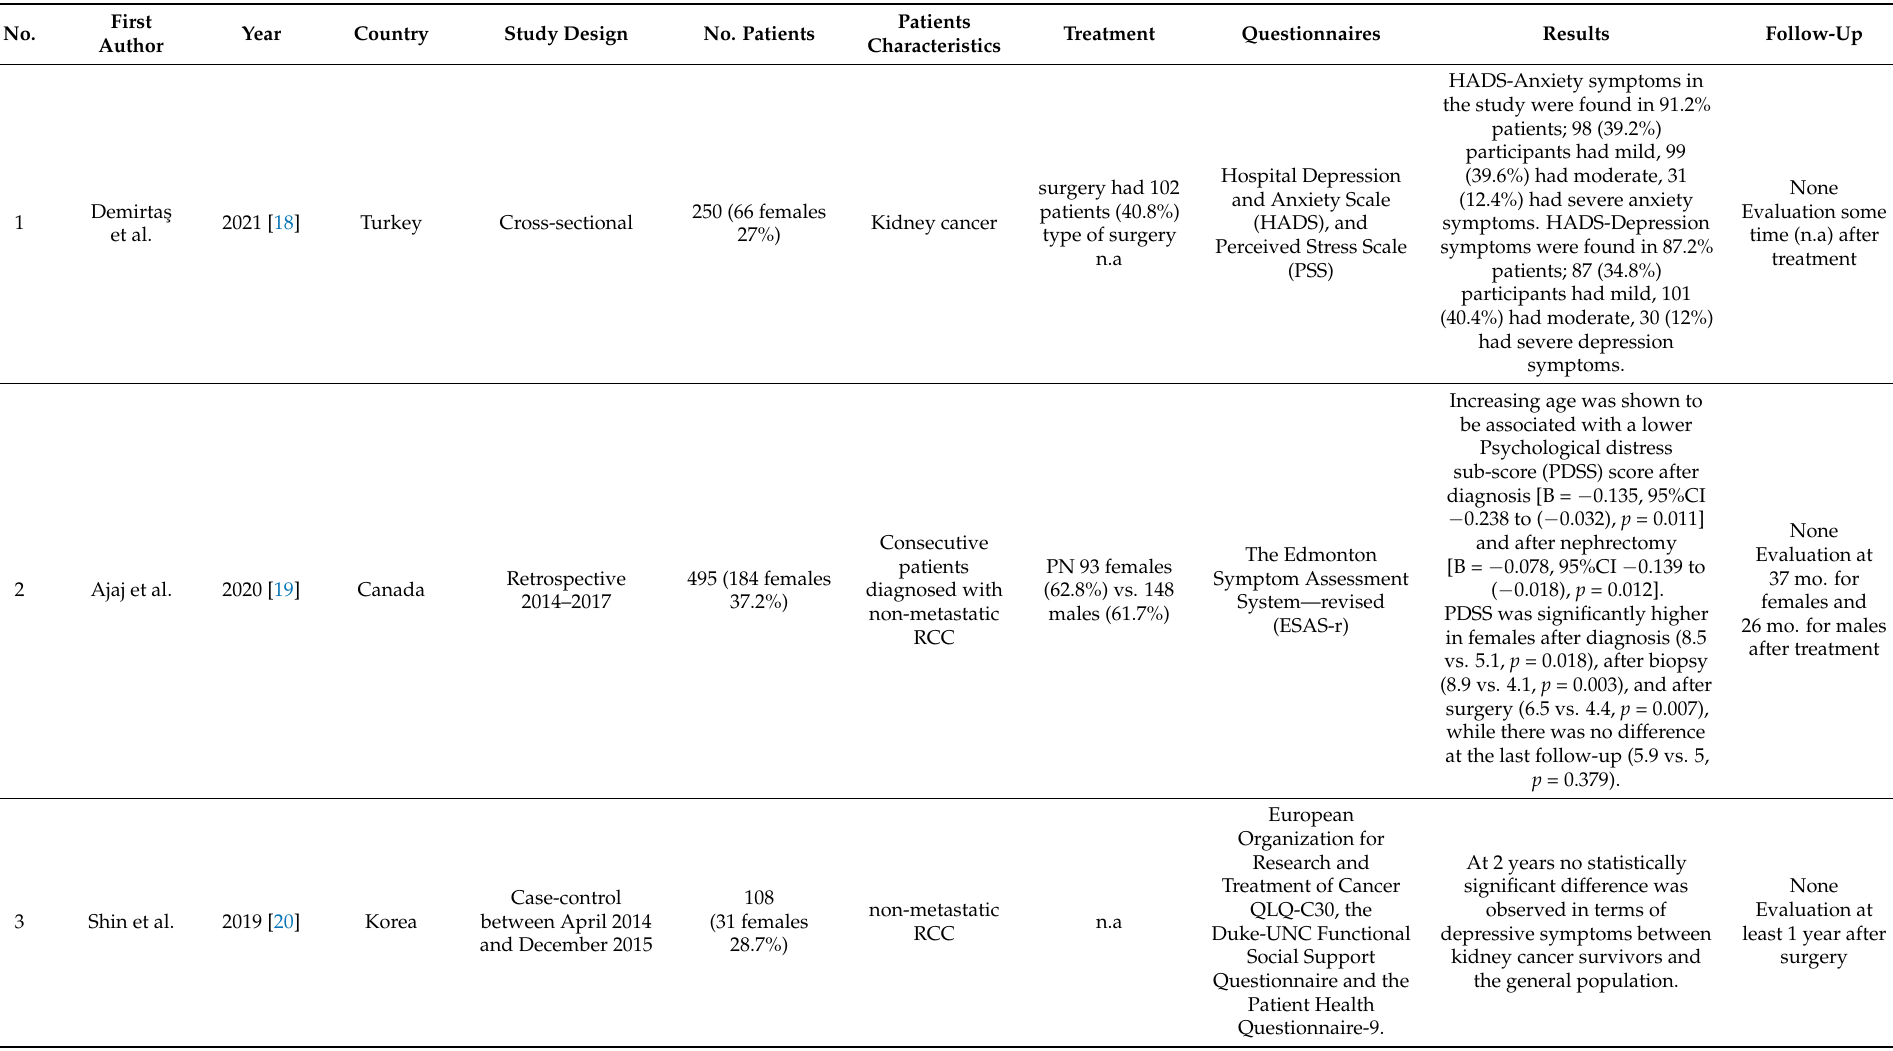
Table 1. Studies that assessed psychological distress, anxiety and/or depression in patients with non-metastatic renal cell carcinoma